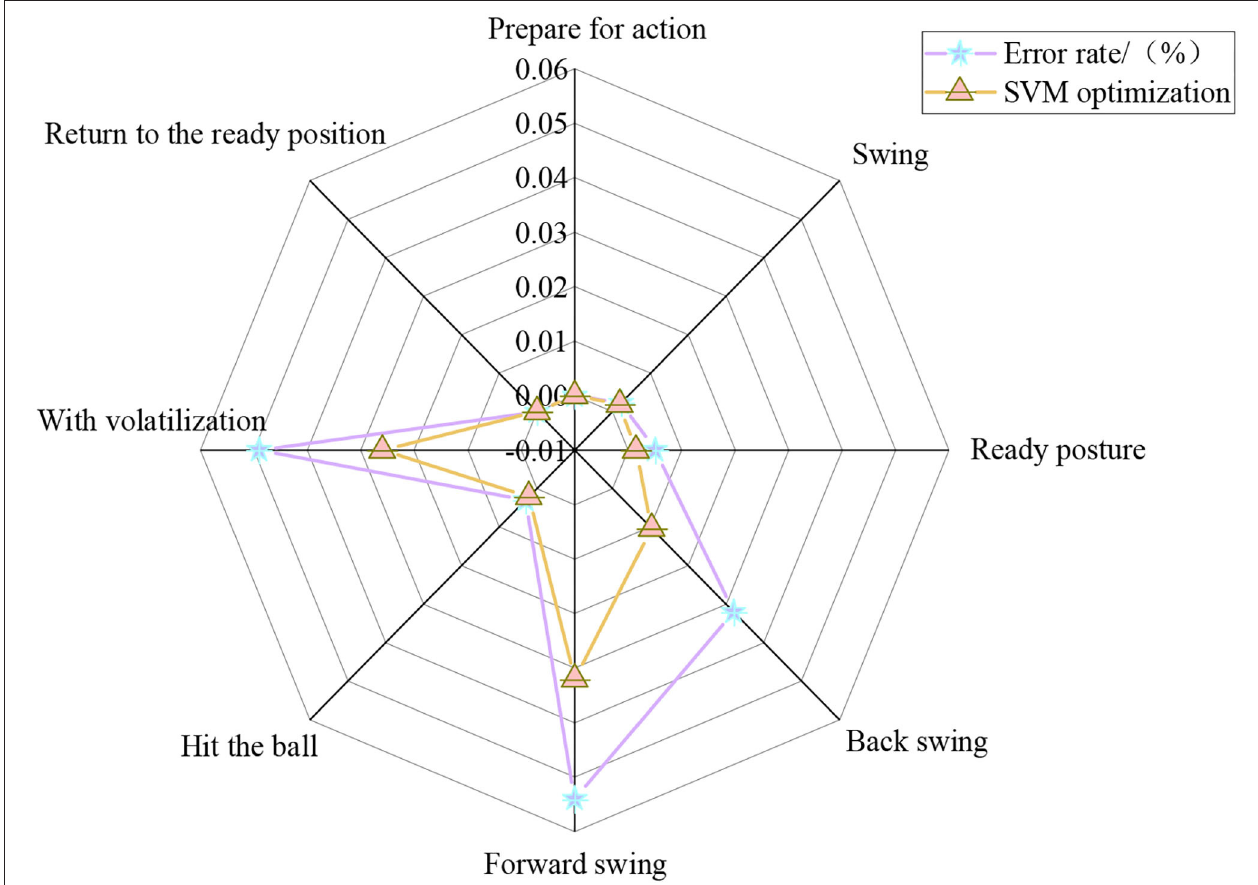
FIGURE 9 | Error rate analysis of 8 kinds of return movements of tennis sports robot based on SVM-O.